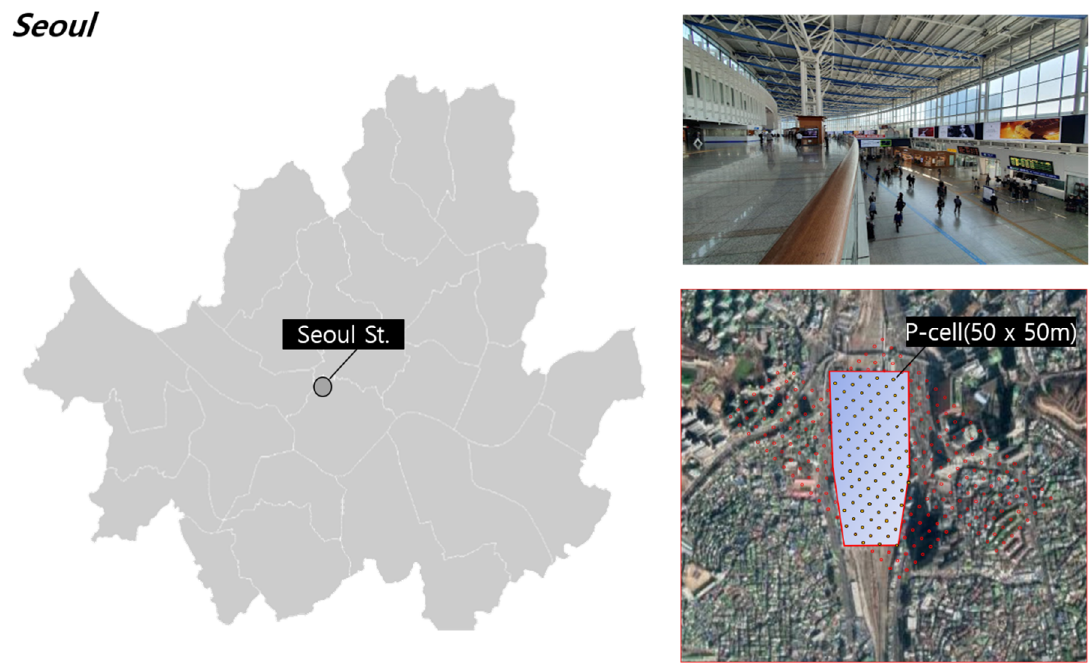
Figure 2. Example of the selected mobile phone centroid of p-cell data within Seoul St. Table 3. Number of records of mobile phone data (averaged) .